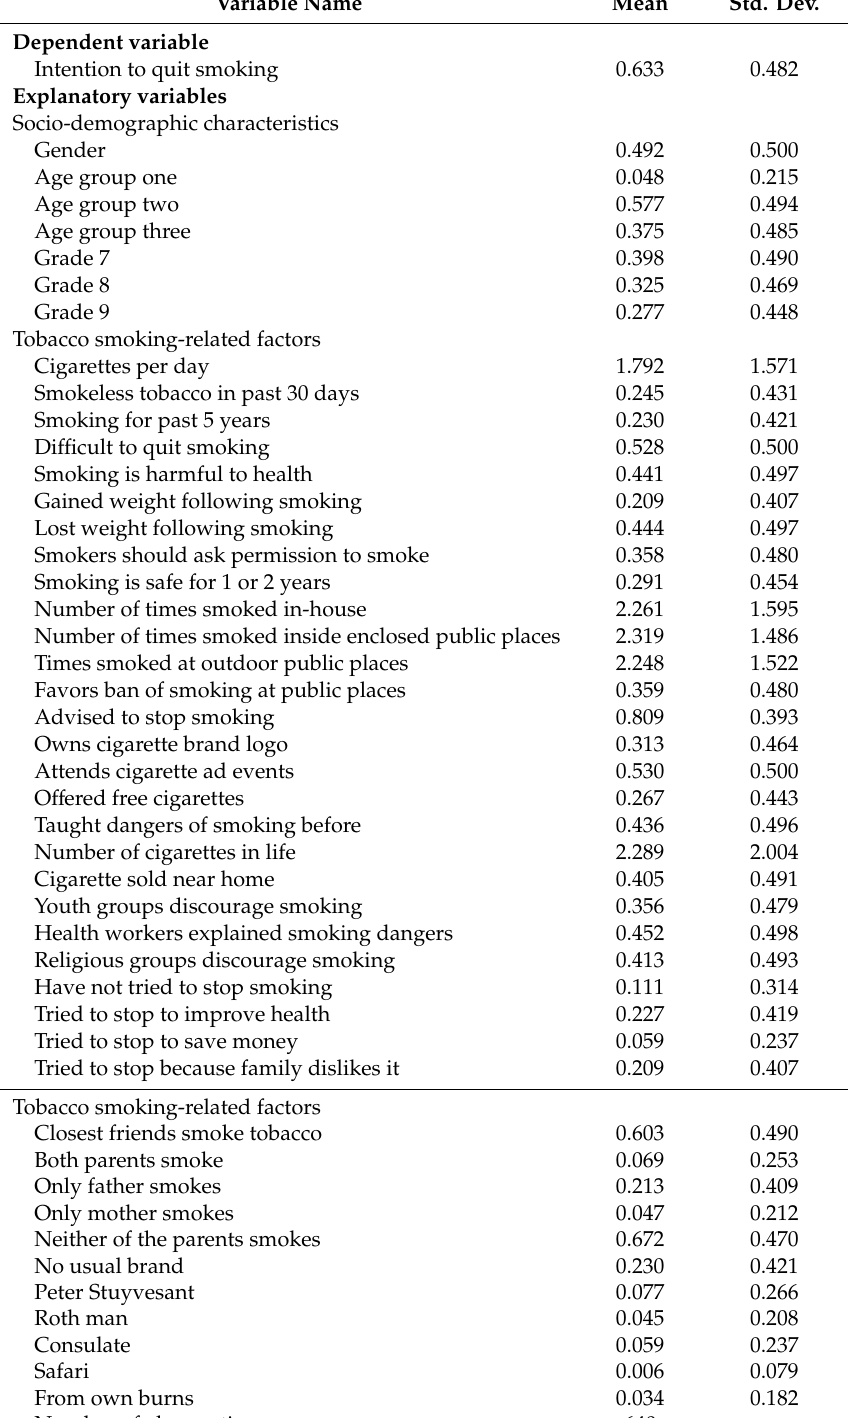
Table 2. Descriptive statistics of variables used in the